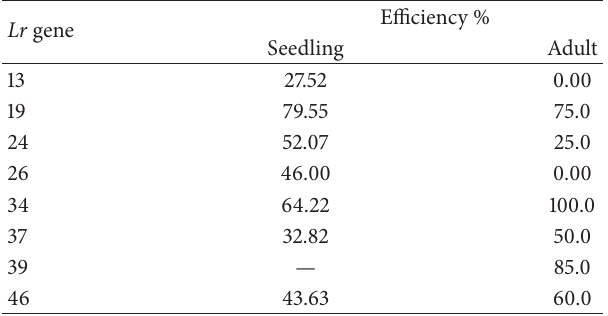
Table 4: Efficacy % of the resistance genes for leaf rust disease at seedling and adult plant stages under the Egyptian